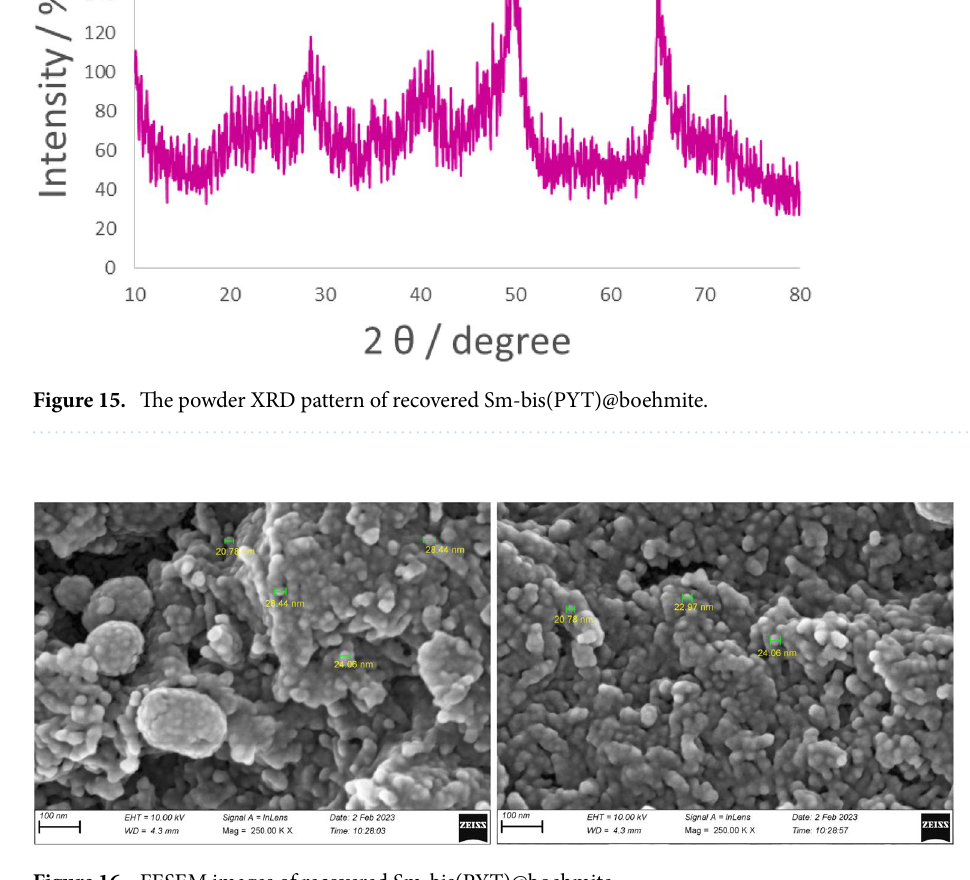
Figure 16. FESEM images of recovered